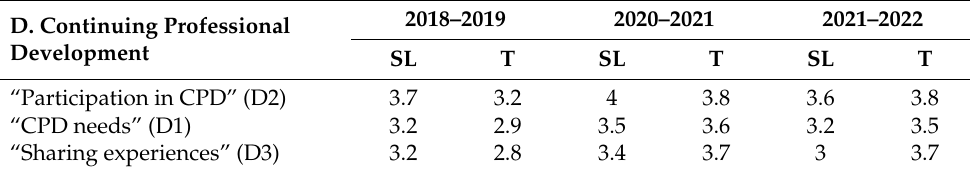
Table 5. Descriptive statistics on continuing professional development.